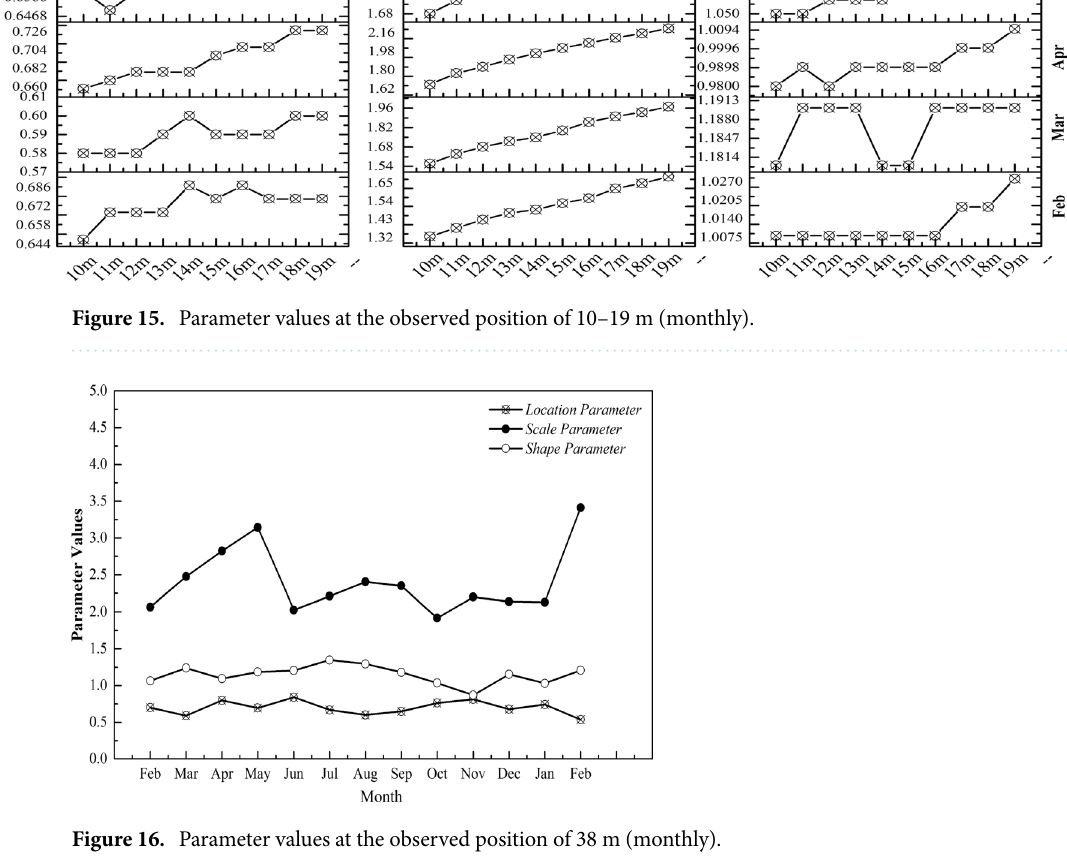
Figure 16. Parameter values at the observed position of 38 m